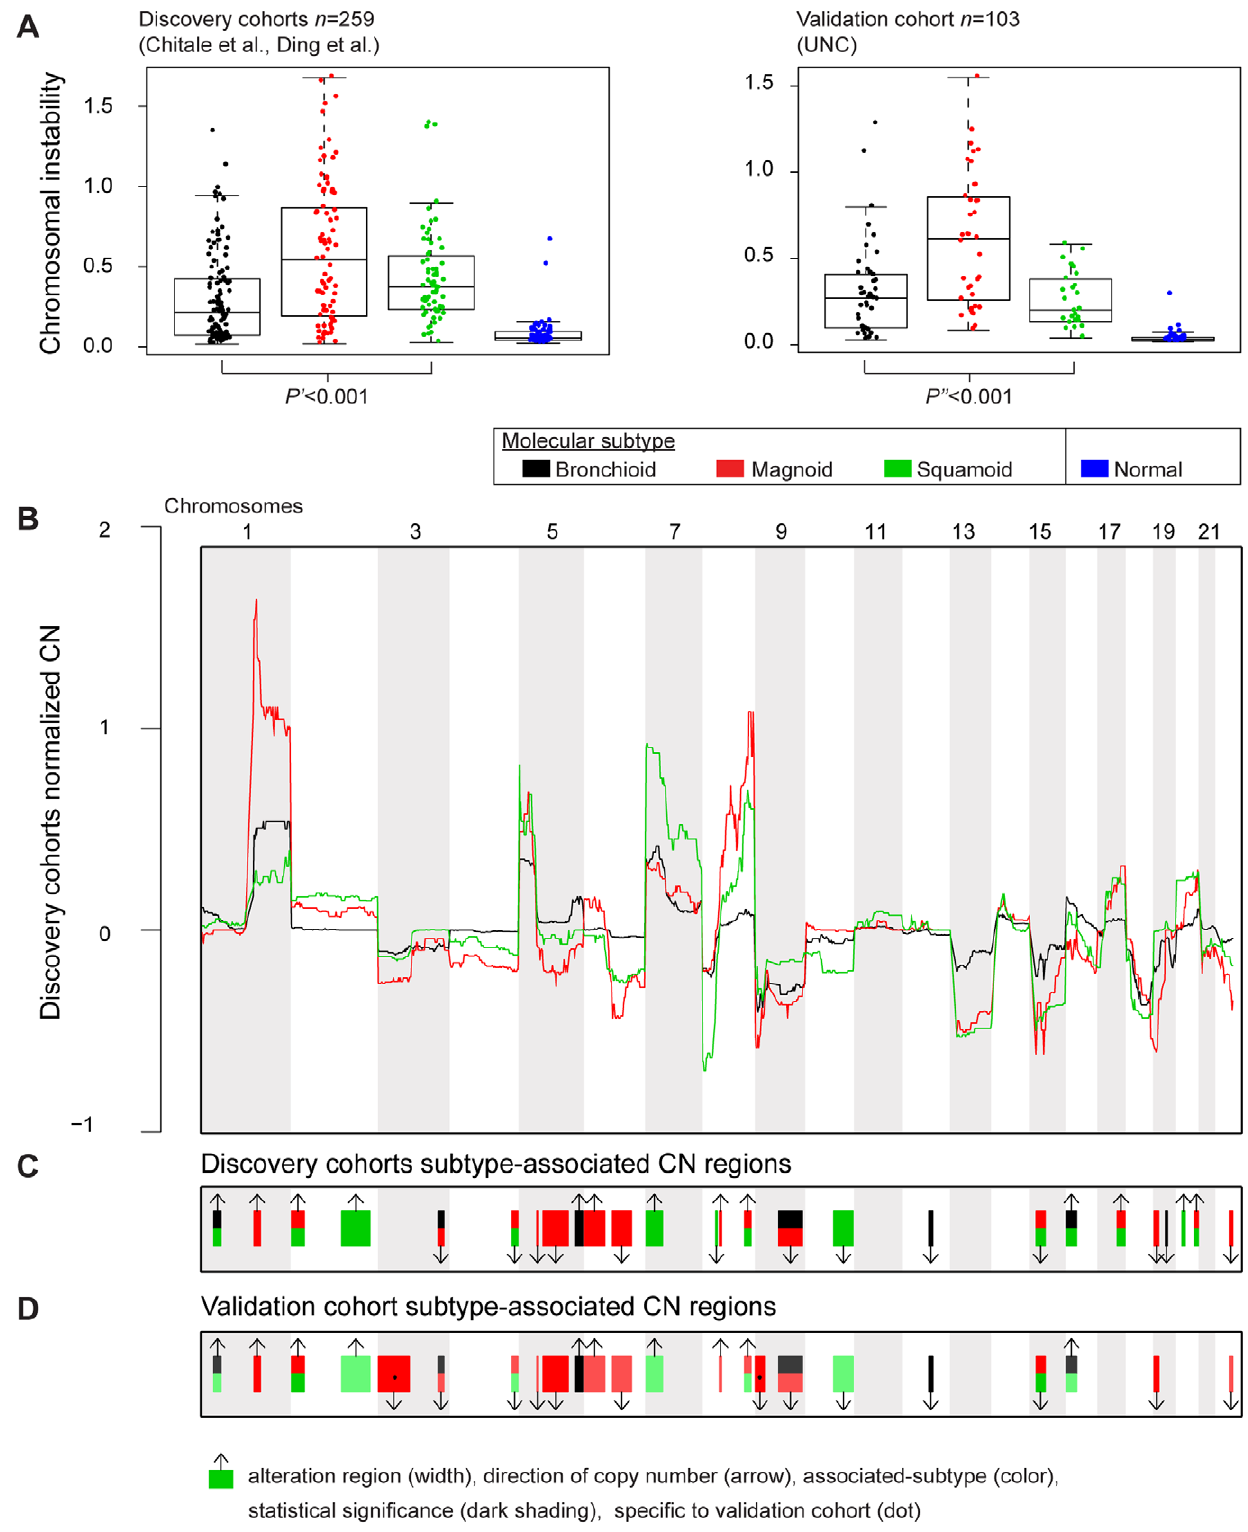
Figure 2. Molecular subtypes compared by chromosomal instability and regional DNA copy number. Chromosomal instability (CIN) grouped by molecular subtypes is displayed for discovery cohorts with CN (Chitale et al., Ding et al.) and the validation cohort (UNC) (A). Subtype CIN was compared by a Kruskal-Wallis test on three subtypes of the discovery cohorts (two-sided P 9 ). A Wilcoxon rank-sum test evaluated the null hypothesis that Magnoid had not greater CIN than other subtypes in the validation cohort (one-sided P 0 ). Normal lung specimens’ CIN are shown for reference. The subtype regional DNA copy number (CN) medians of the discovery cohort are displayed (B). CN values below zero indicate copy